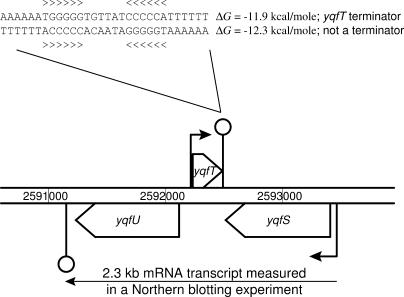
The yqfSU Operon in B. subtilis Consists of the Two Genes yqfS and yqfU, Separated by the Intervening Gene yqfT, Located on the Opposite StrandThe terminator sequence downstream of yqfT is virtually identical to the complementary sequence on the opposite strand. However, a Northern blotting experiment [27] revealed that the complementary sequence does not act as a transcriptional terminator. Arrows indicate transcription start sites; stem-loops represent transcriptional terminators.